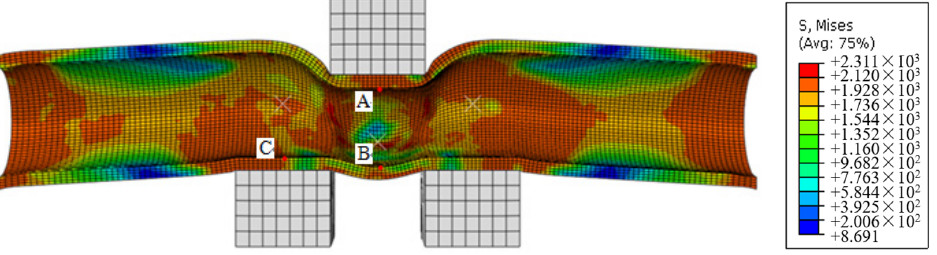
Figure 5. Cloud diagram of equivalent stress distribution after casing shearing: A is the uppermost end of the upper shear fixture; B is the lowest end; C is the uppermost end of the lower shear fix- ture.